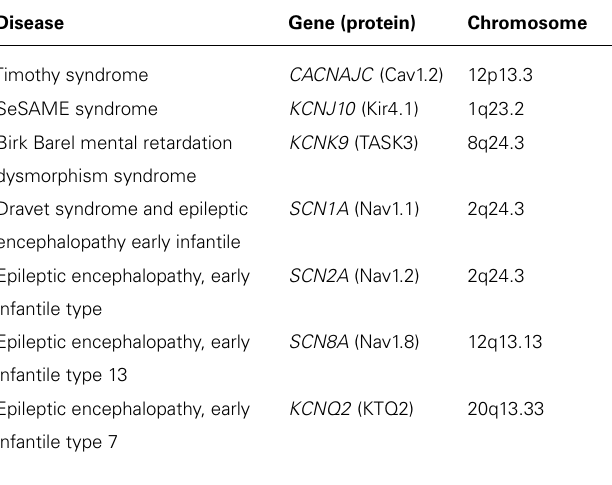
Table 2 | Genetic tests for some neuropsychiatric disorders associated to ion channels dysfunctions (http://www.orpha.net).